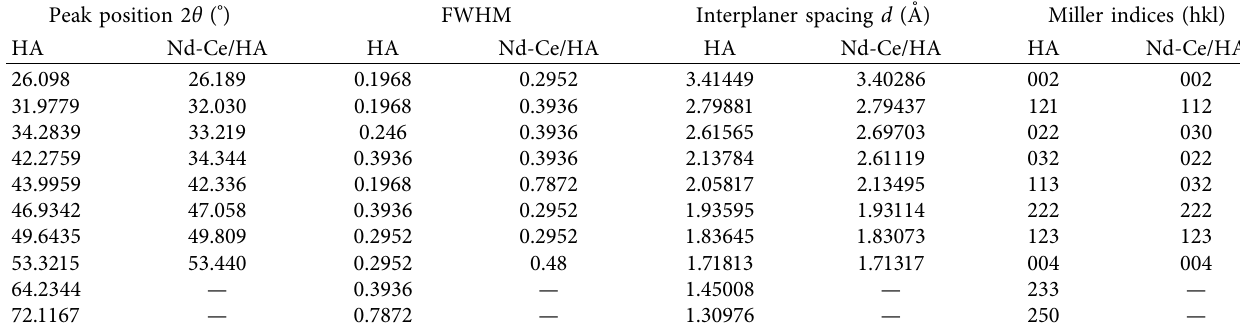
Figure 2: XRD test of (a) prepared hydroxyapatite, (b) Nd-Ce/HA, and (c) crystal structure of Table 1: Essential XRD data of HA and Nd-Ce/HA.